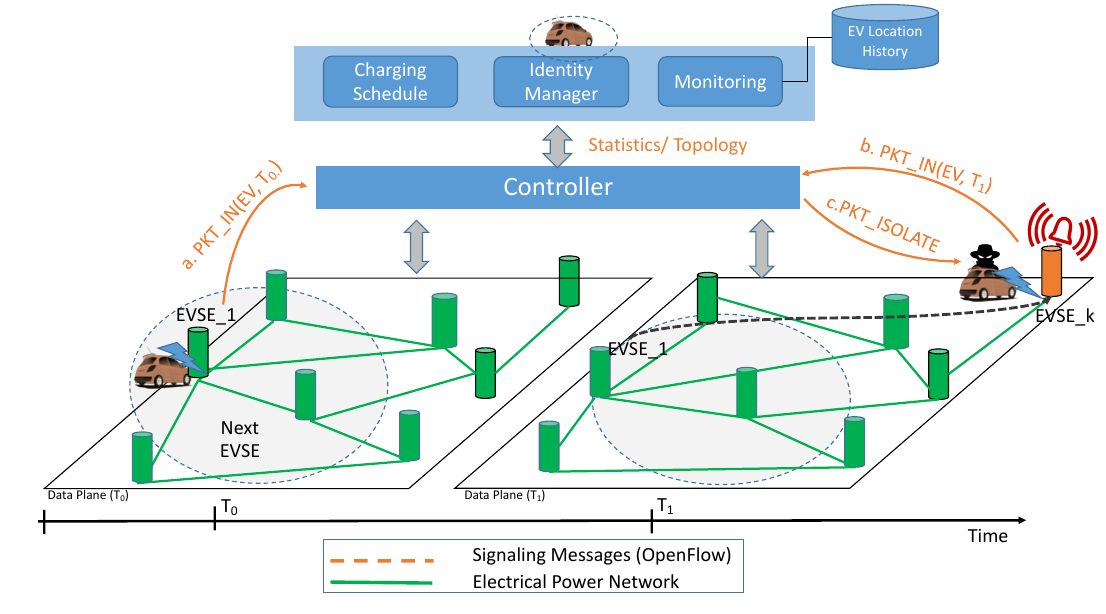
Figure 7. Masquerade attack on